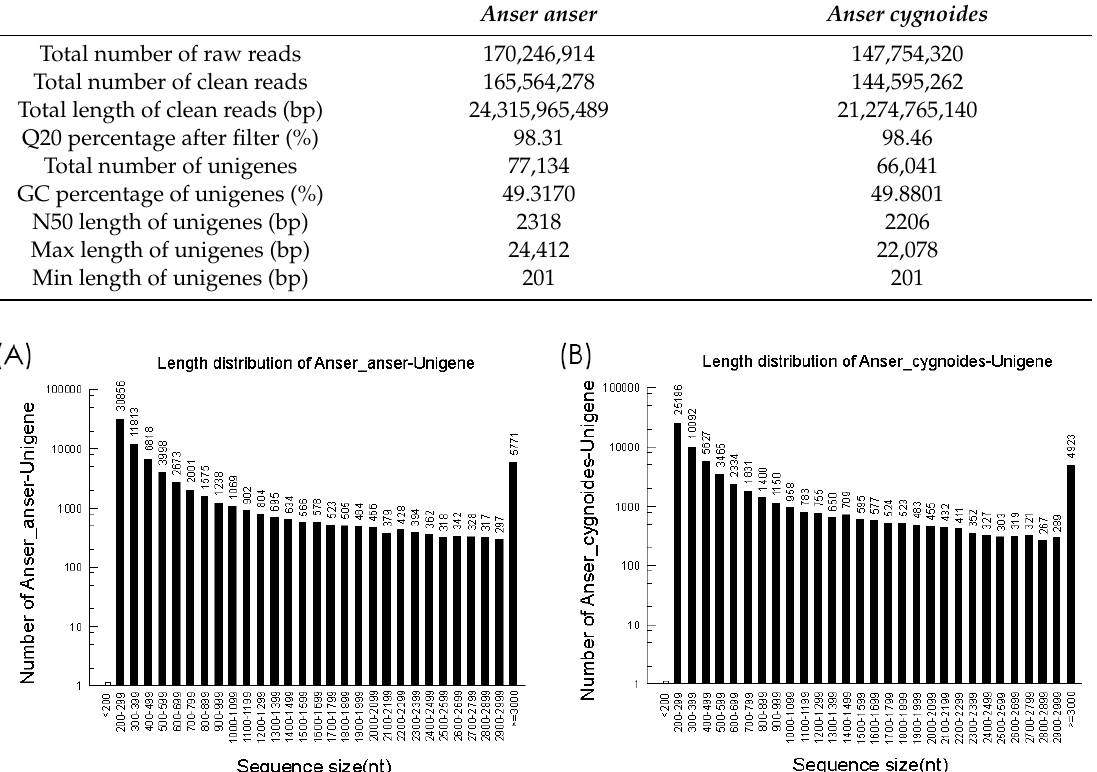
Figure 1. Summary of the unigene length distribution after Trinity assembly ( ≥ 200 nucleotides) for both species. The highest unigene numbers were observed from the 200–299 nucleotides range with 30,856 and 25,186 unigenes, respectively.